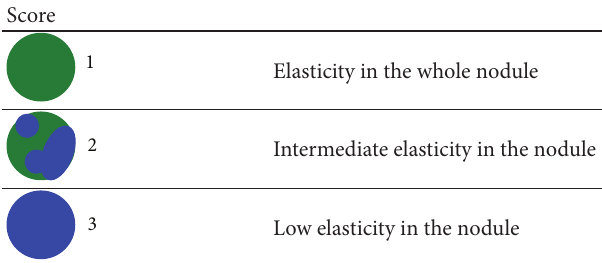
Table 1: The applied standard elastography color scoring system according to Rago criteria [13]. A score of 1 indicates even elasticity in the whole nodule, score 2 elasticity only at the peripheral part of the nodule, and score 3 no elasticity in the nodule and in the posterior shadowing.